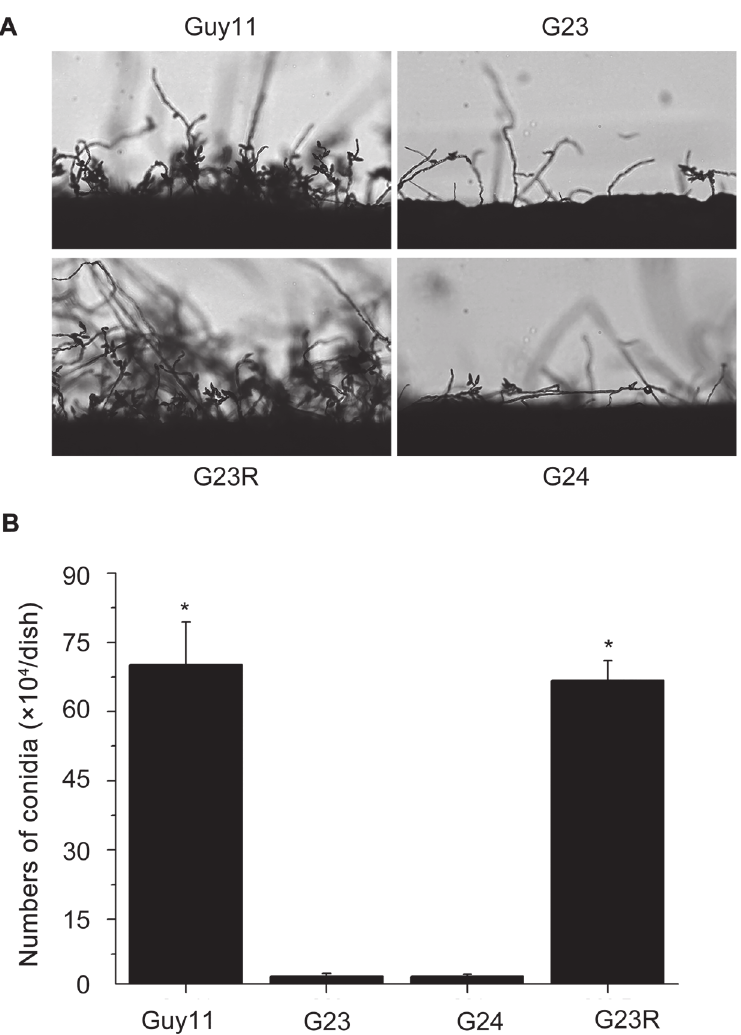
Fig 4. Comparison of the tested M . oryzae strains in conidiation. (A) Development of conidia on conidiophores on CM. Conidia and conidiophores were observed under light microscopy. (B) Statistical analysis of the number of conidia in each 9-cm-diameter dish. The experiments were performed in triplicate. Error bars represent SD. Asterisks in each data column indicate significant differences at p =